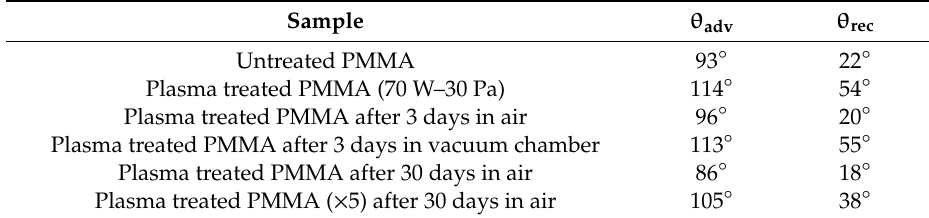
Table 2. Contact angle ageing of the plasma-treated